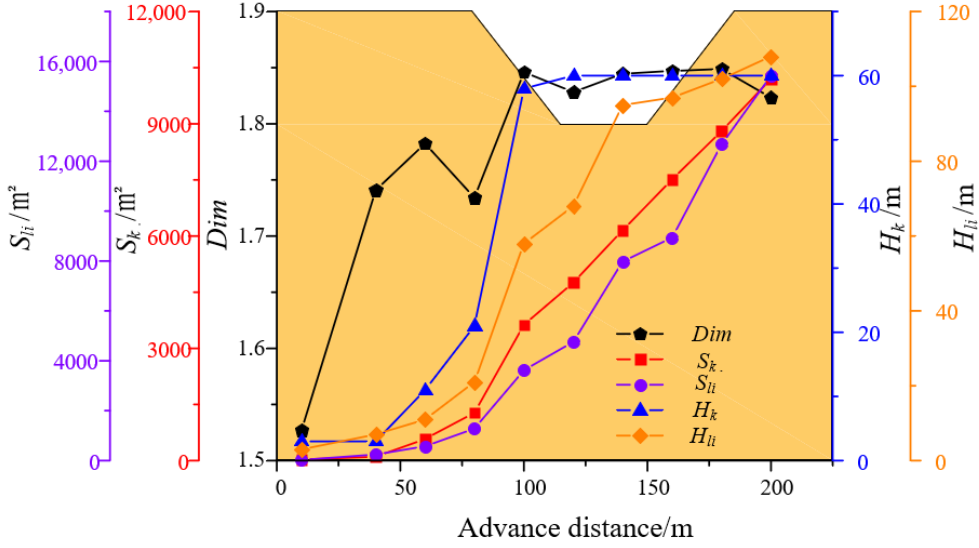
Figure 5. Fractal characteristics of overlying fracture evolution of model 1.